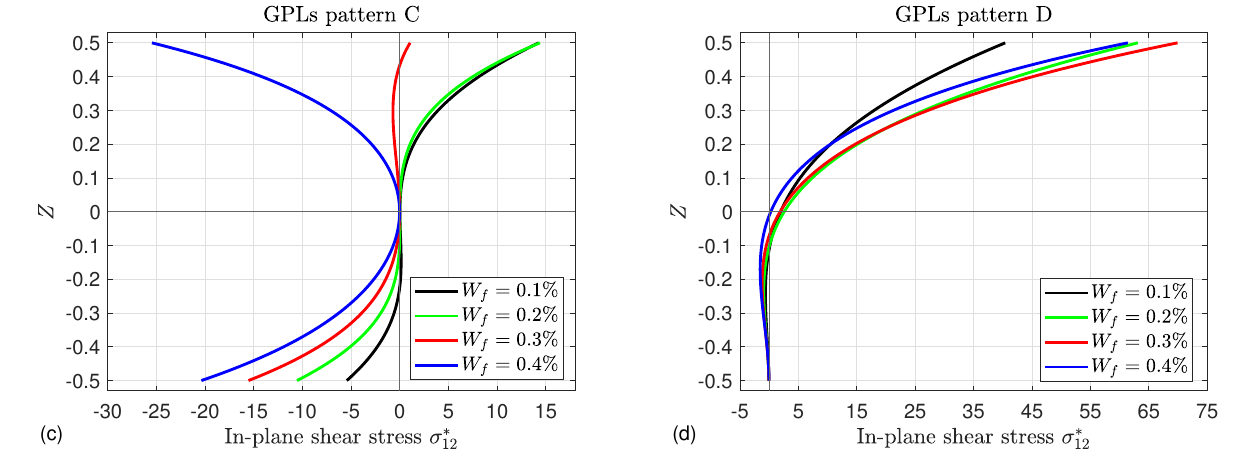
Figure 11. Influence of the GPL weight fraction W f on the in-plane shear stress σ ∗ nanocomposite piezoelectric square plates for different graphene distribution patterns: ( a ) Pattern A, ( b ) Pattern B, ( c ) Pattern C and ( d ) Pattern